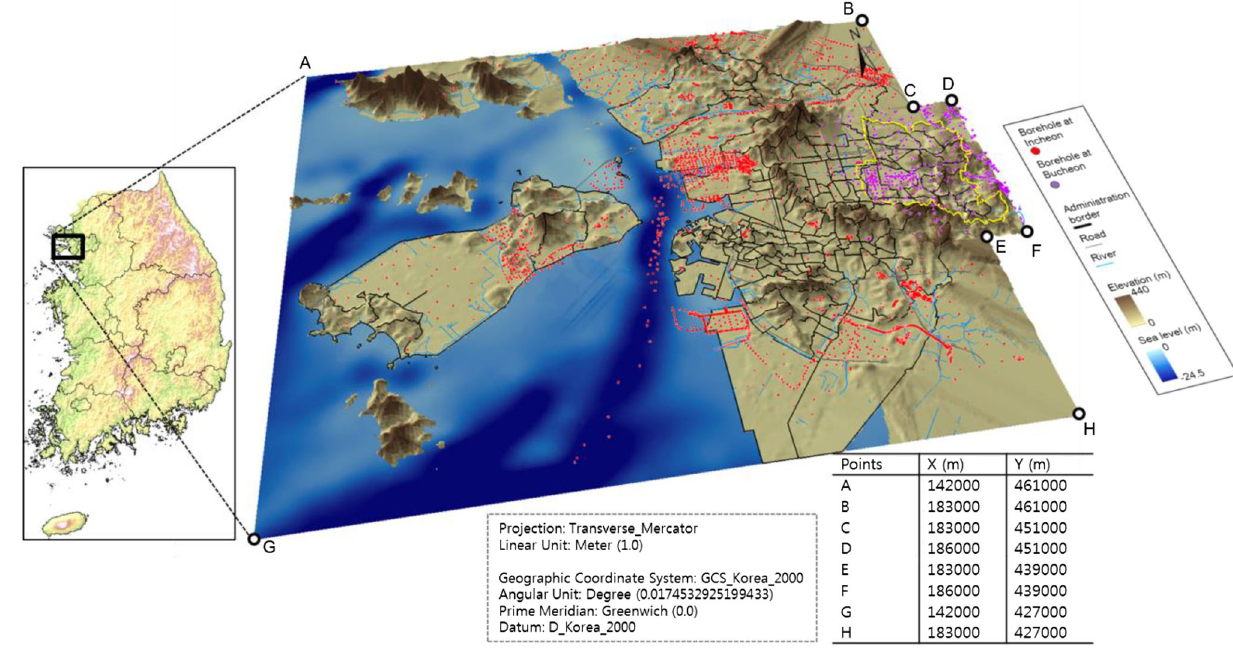
Fig. 5 Spatial distribution of the borehole records in the study area of Incheon and Bucheon, South Korea